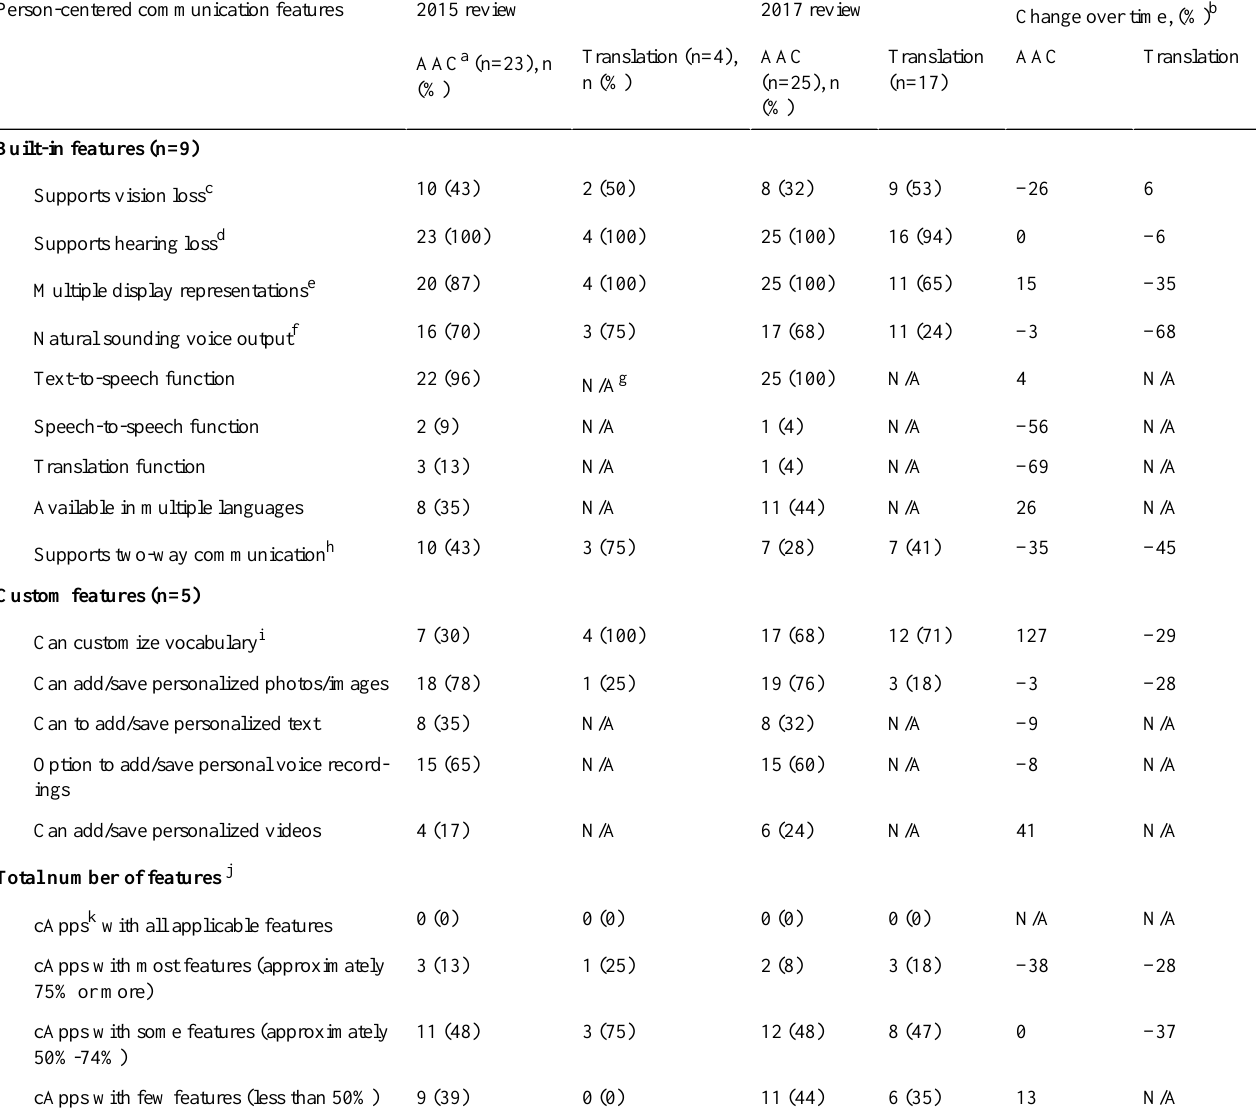
Table 6. Summary of features that support person-centered communication (PCC) in the evaluated communication apps (cApps; this table describes PCC features found in the evaluated cApps during the 2015 review and in the 2017 replication review, as well as evaluates the percentage of cApps with a PCC feature between the 2015 and 2017 reviews. Data were extracted from the Canadian App Store description and during the prepurchase review of the cApps. Feature categories were not mutually exclusive; therefore, 1 app could have several built-in features and/or custom features). Change over time, (%) b 2017 review2015 reviewPerson-centered communication features TranslationAACTranslation (n=17)AAC (%)Translation (n=4), (%)AAC a (n=23), n (n=25), n n (%) Built-in features